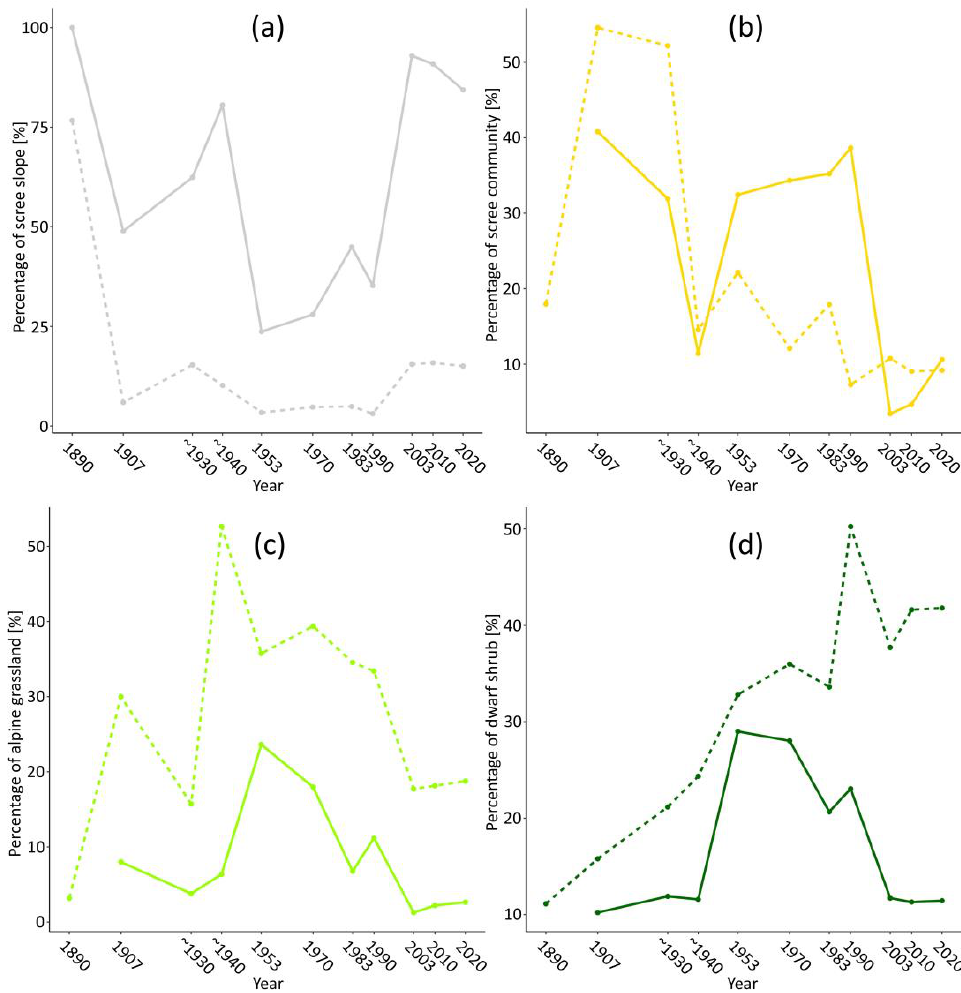
Figure 9. Change in the proportion of the land-cover types within the gully systems (solid line) and non-active areas (dashed line) ( a ) scree slope, ( b ) scree community, ( c ) alpine grassland and ( d ) dwarf shrub.